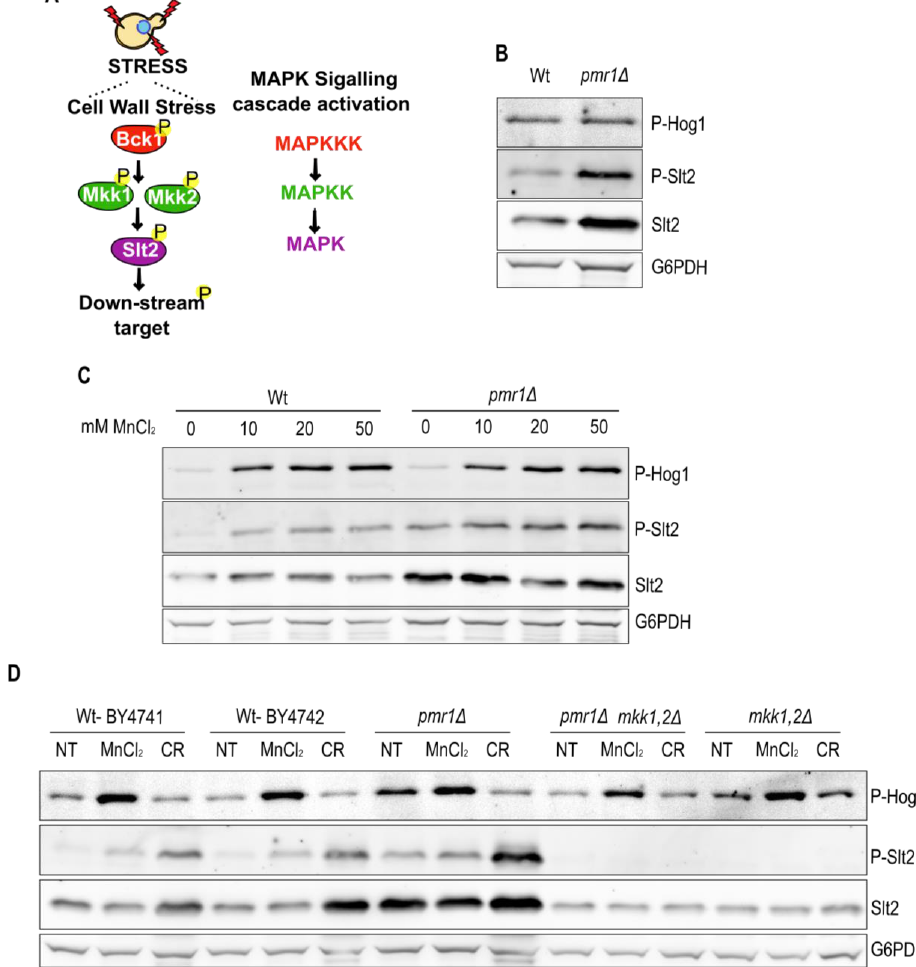
Figure 4. The constitutive Slt2 phosphorylation is a consequence of Pmr1 depletion. ( A ) The schematic outline of the MAPK cell wall integrity signaling cascade in yeast. The relevant kinases are shown. ( B ) Hog1 and Slt2 phosphorylation of exponentially growing Wt and pmr1∆ mutant were analyzed by immunoblotting using phospho-specific antibodies (anti-P-p38 MAPK Thr180/182 and anti-p42/44 MAPK Erk1/2, respectively). The total Slt2 levels were detected with anti-Slt2 antibodies. Glucose-6-phosphate dehydrogenase (G6PDH) levels were used as a loading control. ( C ) Analysis of Hog1 and Slt2 phosphorylation levels in cells treated for 1 h with different MnCl 2 concentration. Description as in B. ( D ) Comparison of MnCl 2 -induced Hog1 and Slt2 phosphorylation in cells lacking the Slt2 upstream kinases Mkk1/2. The non-treated cells (NT) were used as negative control. Congo red (CR) treatment was used as a control to selectively induce Slt2 phosphorylation. Description as in ( B ). 2.4. The Slt2 Target Rlm1 Is Up-Regulated in Cells Lacking